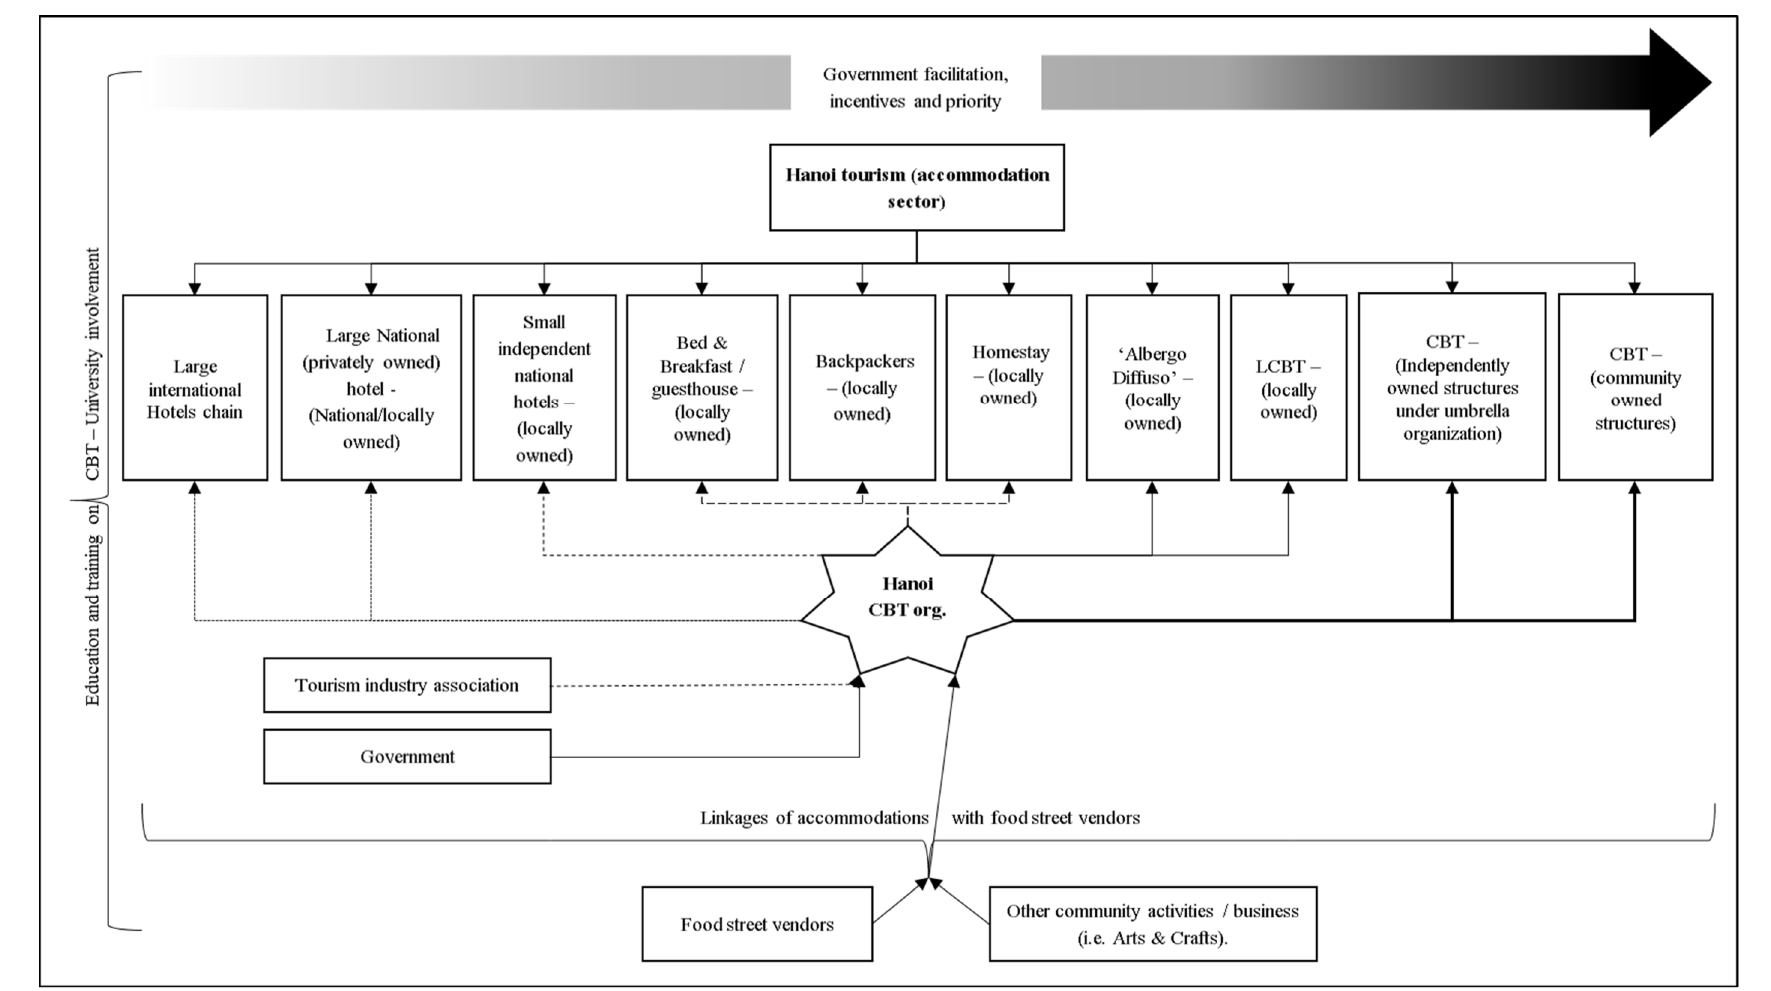
Figure 4. Representation of the proposed Hanoi tourism development approach (focused on the accommodation sector). Source: author’s elaboration (partly from Giampiccoli et al. 2020).